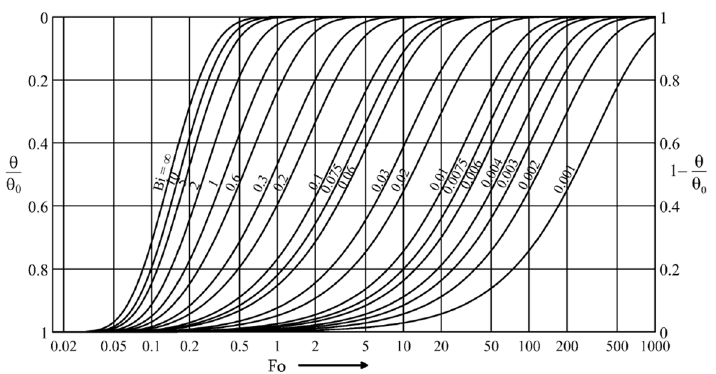
Figure 3. The analytical transient temperature change at the center of a sphere adapted from [11]. The x-axis represents non-dimensional time and is scaled using the thermal